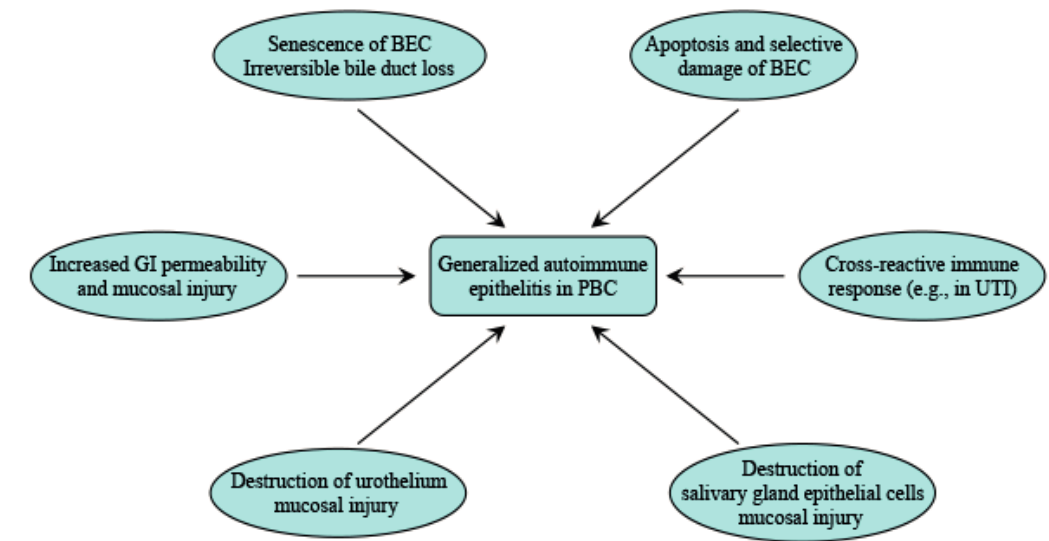
Figure 2. A pathogenetic view of the relationship between autoimmune epithelitis and